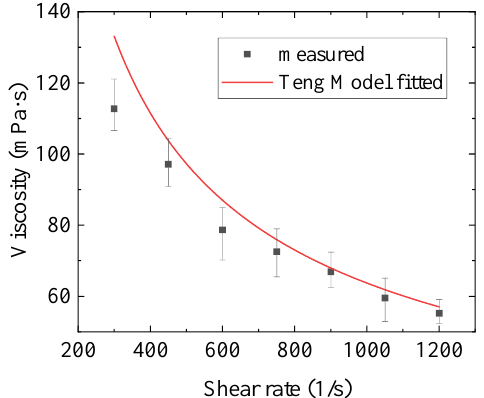
Figure A10. Houska model steady-state fitting.